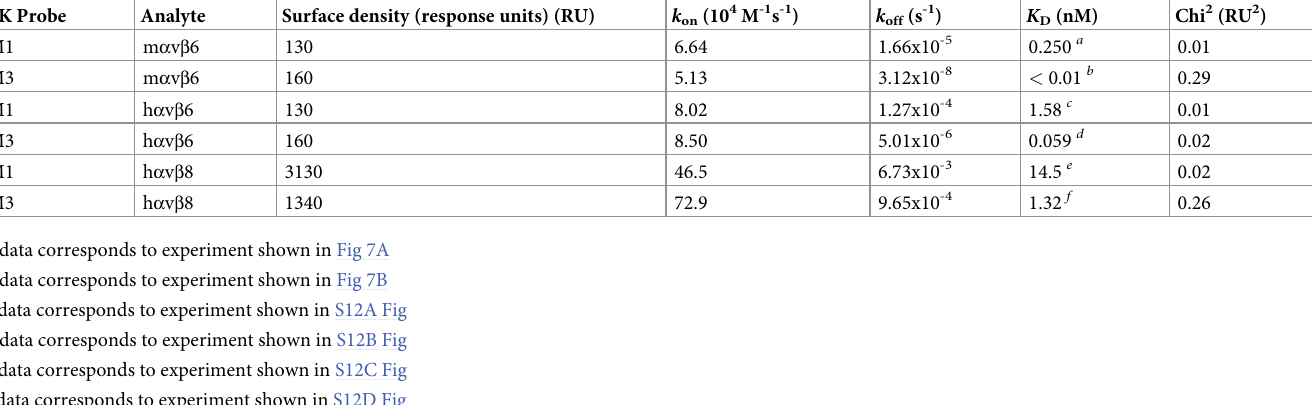
Table 4. SPR kinetic data of soluble integrin binding to immobilized FK-M1 and FK-M3. FK Probe Analyte Surface density (response units) (RU)